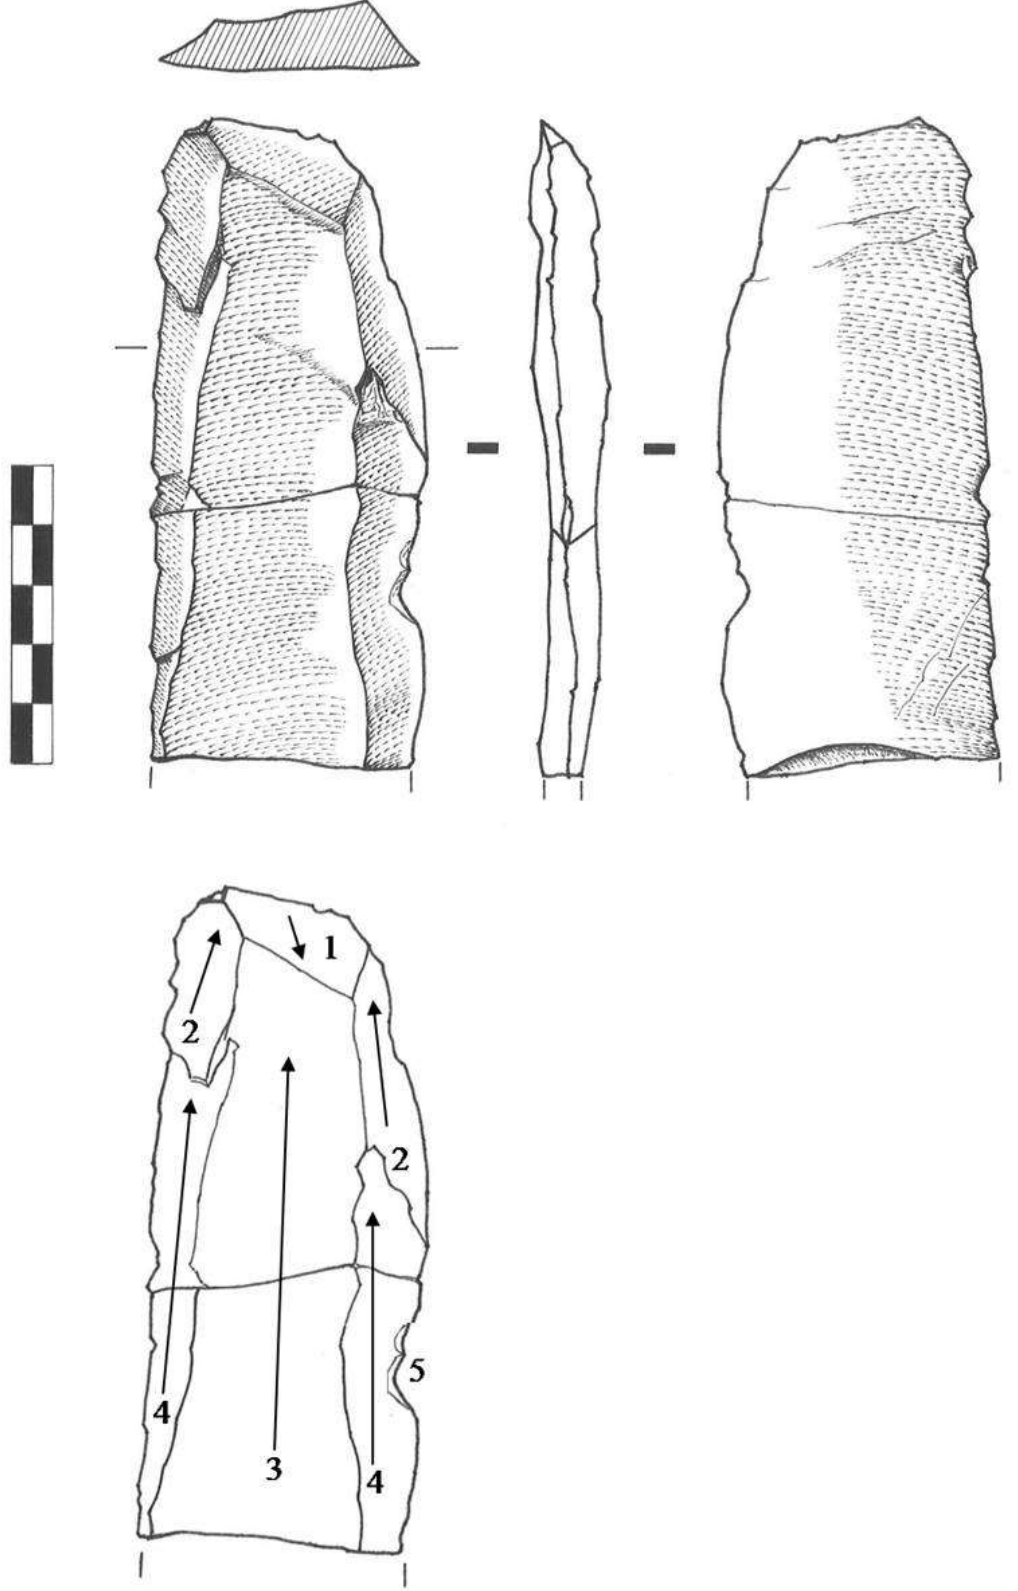
Figure 4. Technological drawing (superior) and diacritic scheme (inferior) of blade resulting from refitting fragments PCO024-a (top fragment) and PCO024-b (bottom fragment). Arrows indicate interpreted direction of the flaking and numbers indicate the order of